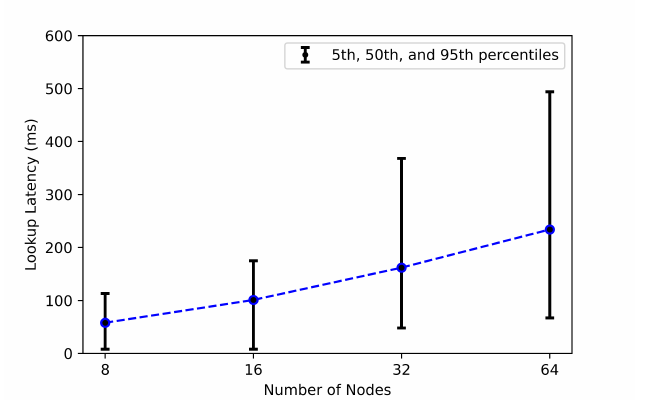
Figure 14. Lookup latency as a function of the total number of